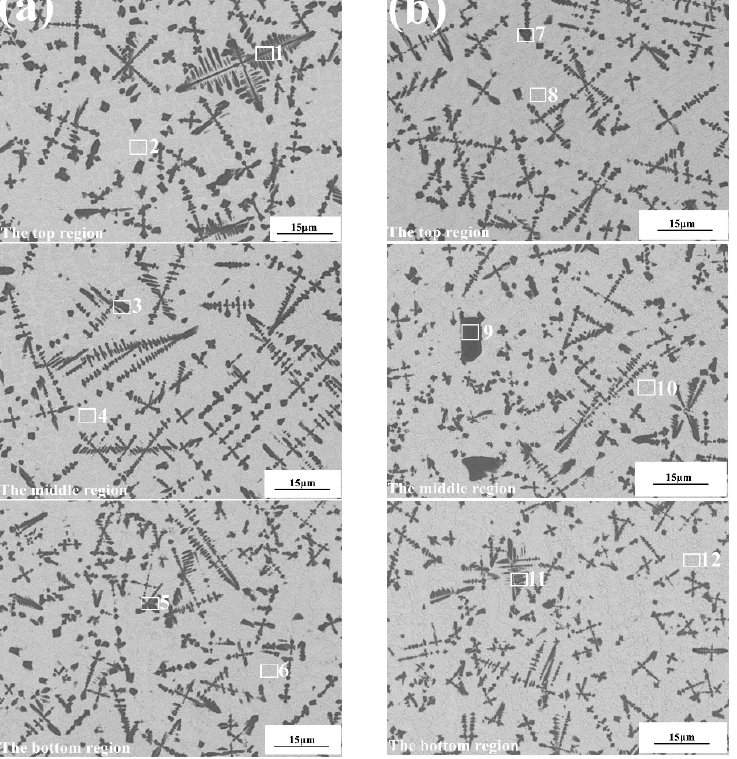
Figure 7. Microstructure of cladding layers at different laser powers: ( a ) 2# sample: 1.4 kW, 7 mm/s, 1000 L/h, 20% TiC; ( b ) 4# sample: 1.2 kW, 7 mm/s, 1000 L/h, 20% TiC.